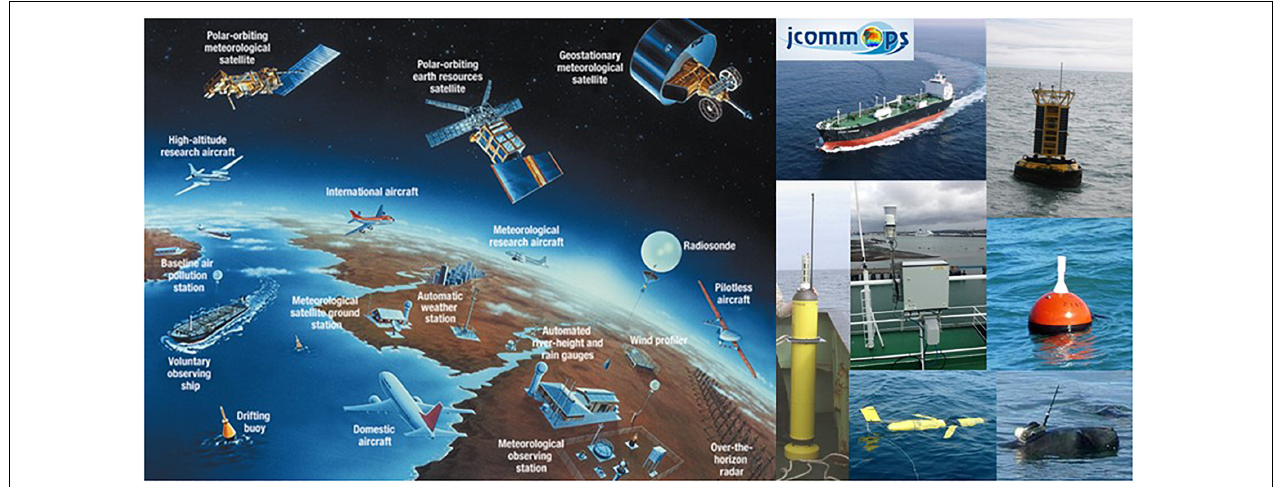
FIGURE 5 | (Left) schematic of the components of the WMO Global Observing System (© World Meteorological Organization) and (right) of the Global Ocean Observing System that presently contribute to WIGOS.